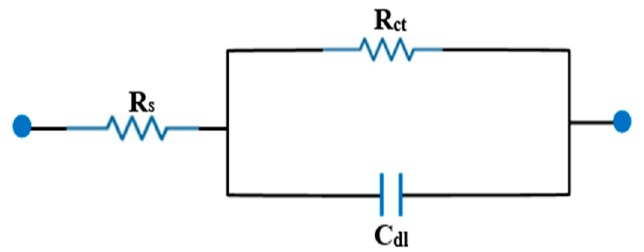
Figure 8. Equivalent circuit diagram. Table 2. EIS parameters of low-carbon steel corrosion in 1 M HCl in the absence and presence of CoO/Co 3 O 4 NPs at 298 and 333 K.